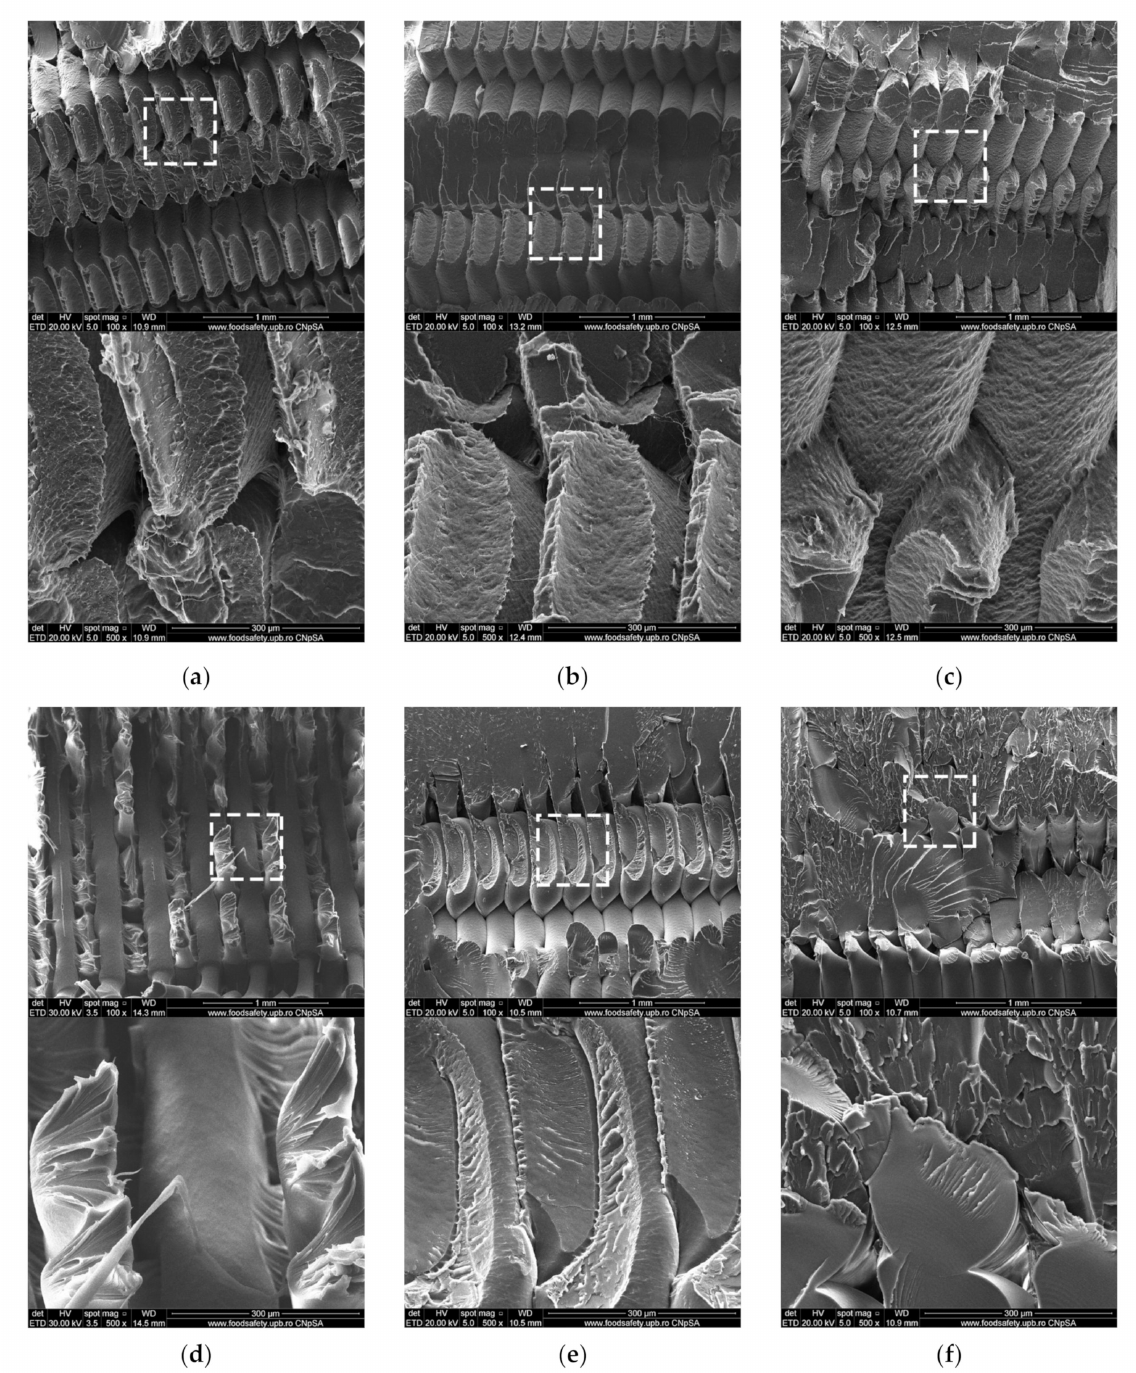
Figure 9. Scanning Electron Microscopy analysis of fractured 3D printed samples ( a ) PLA sample from control group ( b ) PLA sample from UV-C exposed group ( c ) PLA sample from UV-C exposed group; ( d ) PETG sample from control group; ( e ) PETG sample from UV-C exposed group; ( f ) PETG sample from UV-C exposed